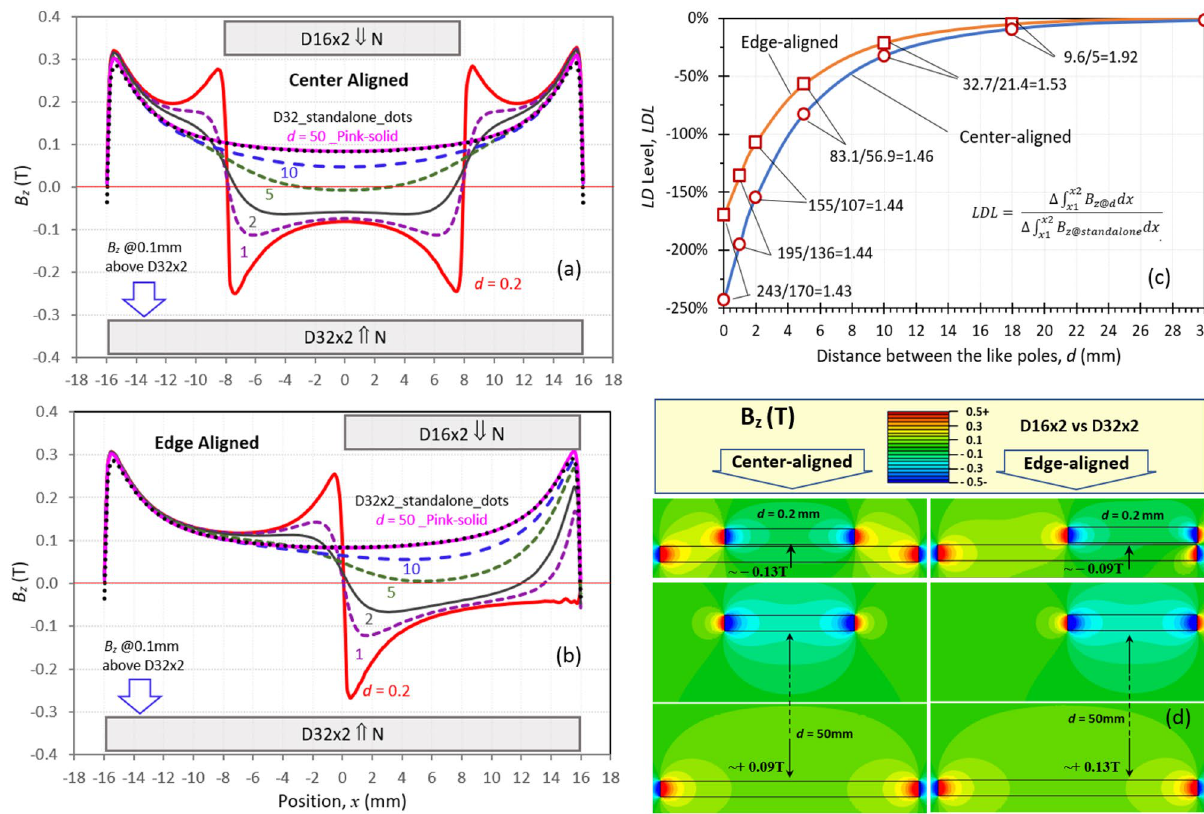
Figure 4. The B z distributions of the center-aligned D16 × 2 and D32 × 2 pair with various distances show that the smaller the distance is, the stronger the LD and the EE (edge effect) are. The LDL is defined as the ratio of x 2 B z dx of a standalone D32 × 2, calculated using Eq. (1), with the details B z dx at the distance d over the (cid:31) x 2 (cid:31) (cid:31) x 1 x 1 for this case shown here: LDL = positions where the LD starts and ends. Plots for the center aligned pairs have x 1 = − 8mm and x 2 = 8mm ( a ), and for the edge aligned pairs have x 1 = 0mm and x 2 = 16mm ( b ). The |LDL| of the center-aligned pairs is as large as 243% at d = 0.2 mm, and the center-aligned pairs have much larger | LDL | than the edge-aligned pairs. The ratios of |LDL| cente r / |LDL| edge range from 1.43 to 1.92 for d = 0.2 to 18 mm ( c ). The 2D B z maps at the cross-section through a diameter for both center- and edge-aligned with d = 0.2 and 50 mm are displayed in ( d ), showing the LD and the EE Figure 4 shows the simulated B z vs. the position x for the like poles of D16 × 2 vs. D32 × 2 and the layout of the magnets (this is the same pair shown in Fig. 1(b). The B z is calculated along a line 0.1 mm above a diameter of D32 × 2. Figure 4(a) displays the B z in the center-aligned pair with six distances between the like poles ( d = 0.2, 1, 2, 5, 10, and 50 mm). For a standalone D32 × 2, the B z values are positive across the whole range of position x from − 16 to + 16 mm, showing up as black dots, almost overlapping on the curve of B z at d = 50 mm. Pairing with like poles, the B z vectors of D32 × 2 and D16 × 2 are opposite, thus repelling each other. As D16 × 2 has a higher | P c | (0.28) than D32 × 2’s | P c | (0.13), the stronger fluxes of D16 × 2 push the B z near D32 × 2 from posi- tive to negative when the distance d is ≤ 5 mm. At d = 0.2 mm, the edge fluxes of D16 × 2 give a powerful push, making the curve of B z vs. x near D32 × 2 look like a pair of upside-down cat ears. Figure 4(b) shows the B z of edge-aligned like poles, and the LD effect is weaker than that of the center-aligned poles. At d = 0.2 mm, the B z curve is in the shape of only one cat ear. The LD level, LDL, of D32 × 2 for both center- and edge-aligned cases is shown in Fig. 4(c). The LDL is defined x 2 B z dx of the standalone D32 × 2, and the standalone magnet B z dx at the distance d over (cid:31) x 2 as the ratio of (cid:31) (cid:31) x 1 x 1 is used as the base. The following equation is established to calculate the LDL , and the details of this individual case are given in the caption of Fig. 4.